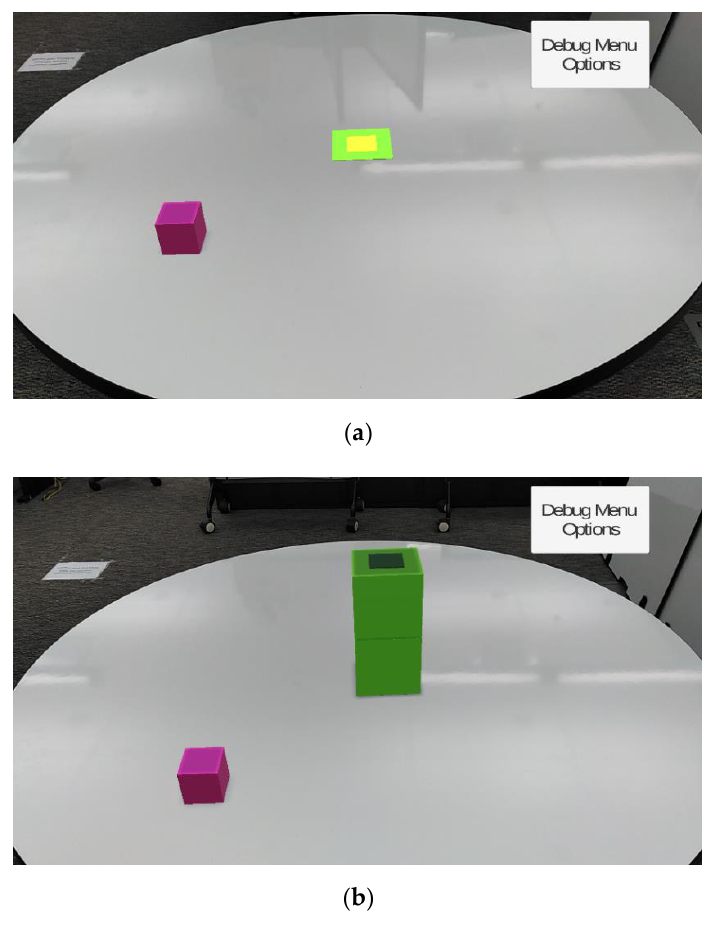
Figure 2. The test suite implementation. ( a ) Initial user interface screen; ( b ) user running a test